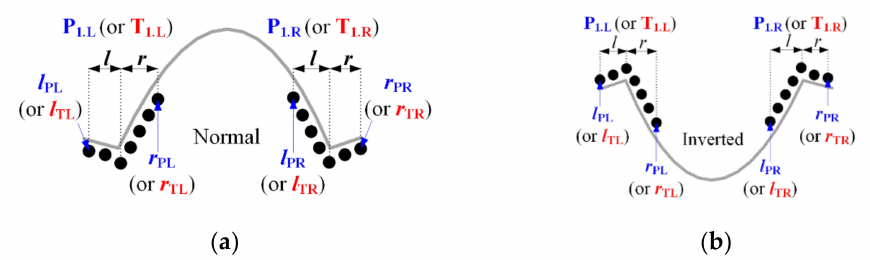
Figure 11. Asymmetric point filters for onset and offset detection of the P- and T-wave; ( a ) normal type and ( b ) inverted